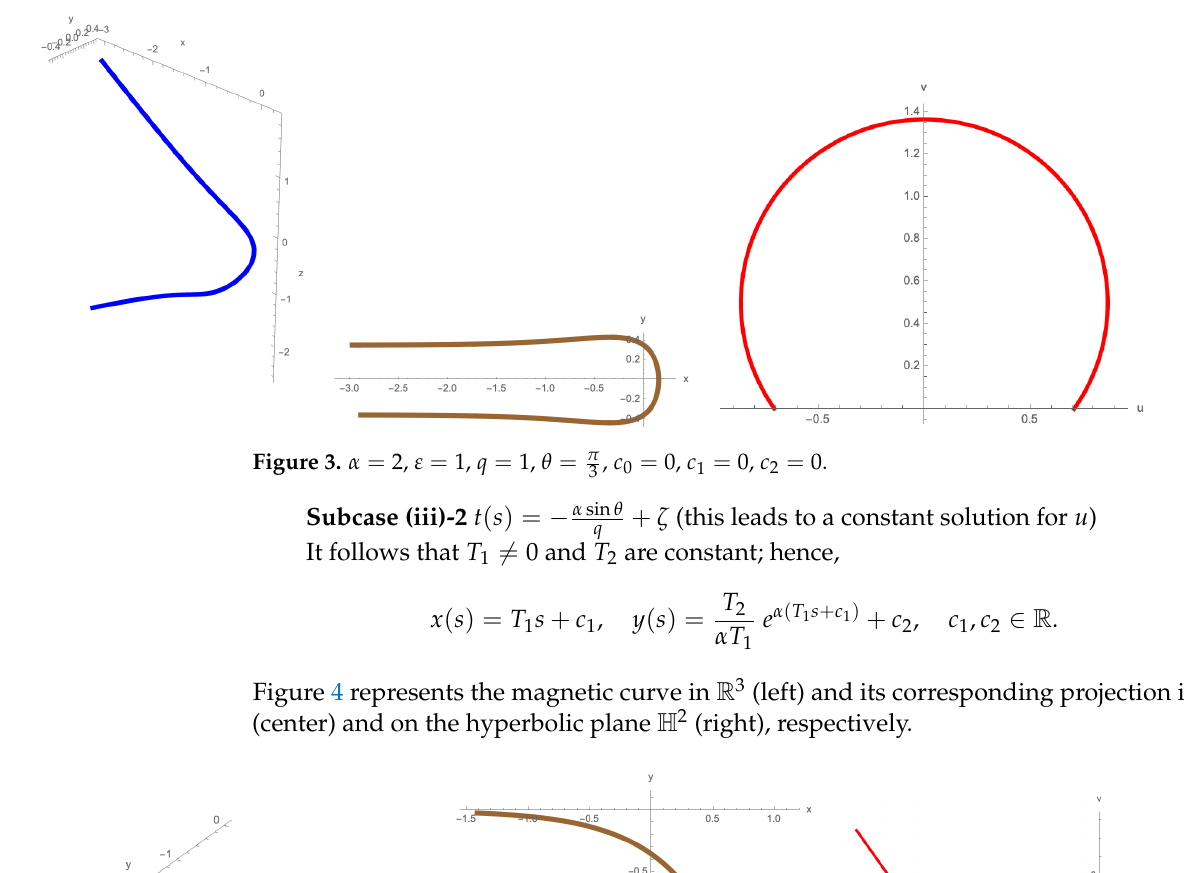
, c 0 = 0, c 1 = 0, c 2 = 3